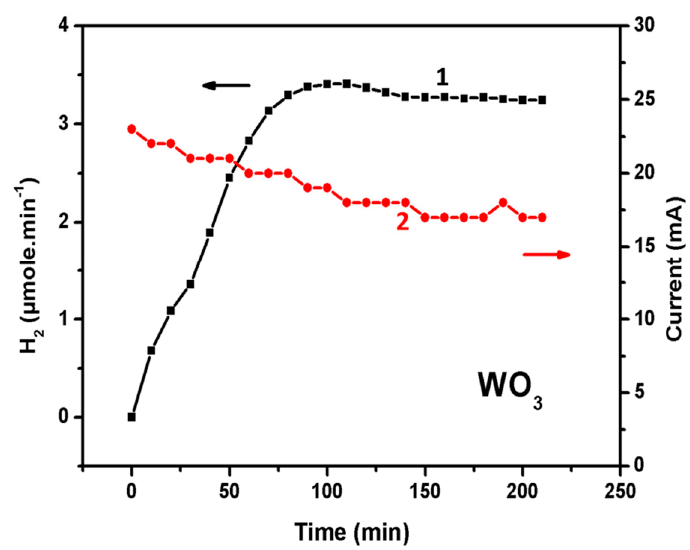
Figure 7. Photoelectrocatalytic hydrogen production using the reactor of Figure 2, equipped with either a CdS/TiO 2 or a WO 3 photoanode. The counter-electrode was a carbon cloth covered (one side) with mesoporous carbon. The active area of both the photoanodes and counter-electrode was 15 cm 2 (3 cm × 5 cm). The electrolyte was 0.5 M NaOH in the case of CdS/TiO 2 , and 0.5 M Na 2 SO 4 in the case of WO 3 . The same electrolyte filled both reactor compartments; however, 5% v/v ethanol was added into the electrolyte of the anode compartment. Curve 1 gives the hydrogen production rate, and curve 2 the corresponding photocurrent as a function of time. The applied bias was 0.0 V vs. Ag/AgCl in the case of CdS/TiO 2 and 1.0 V vs. Ag/AgCl in the case of WO 3 . All data of have been recorded with 2% error.